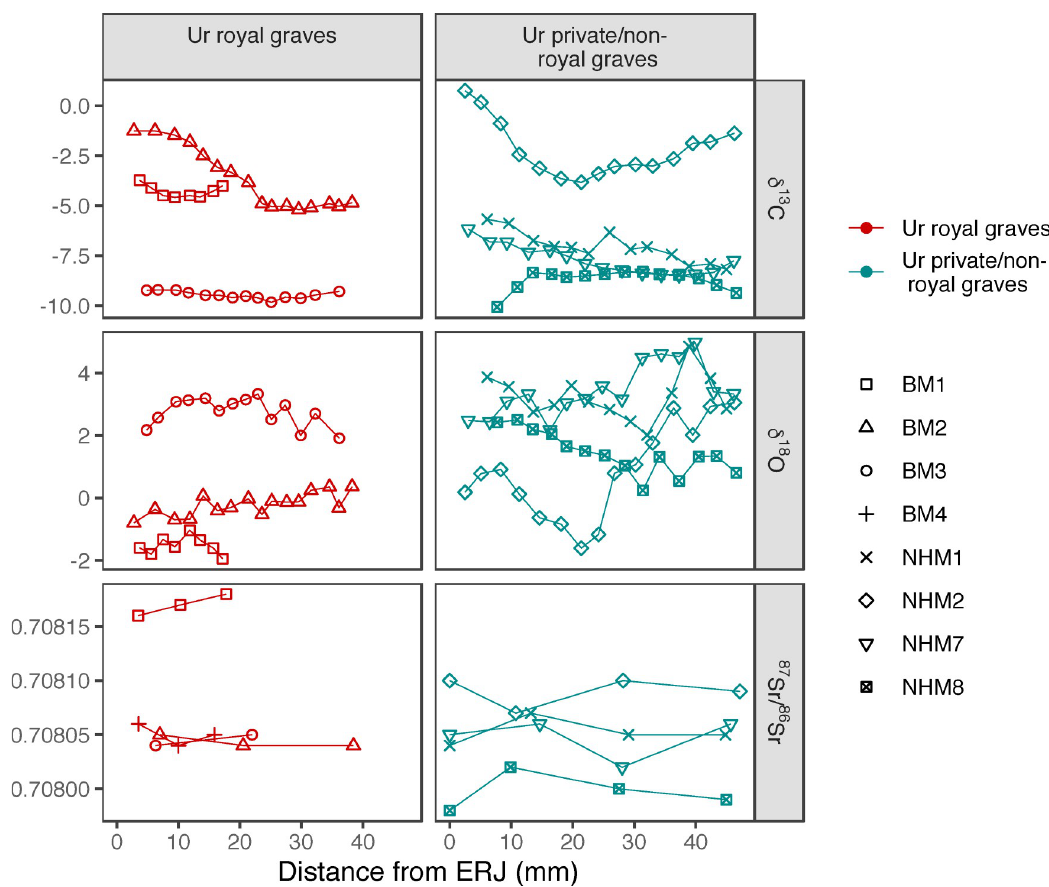
Fig 8. (intrateeth_COSr_labels.eps): Bovine enamel sequential intra-tooth carbon, oxygen and strontium isotope results plotted as a function of distance from the enamel root junction (ERJ), separated by individual (different shapes) and the royal/non-royal graves (different